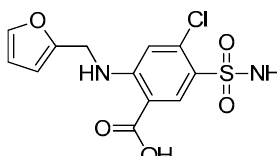
Figure 1. Chemical structure of furosemide.